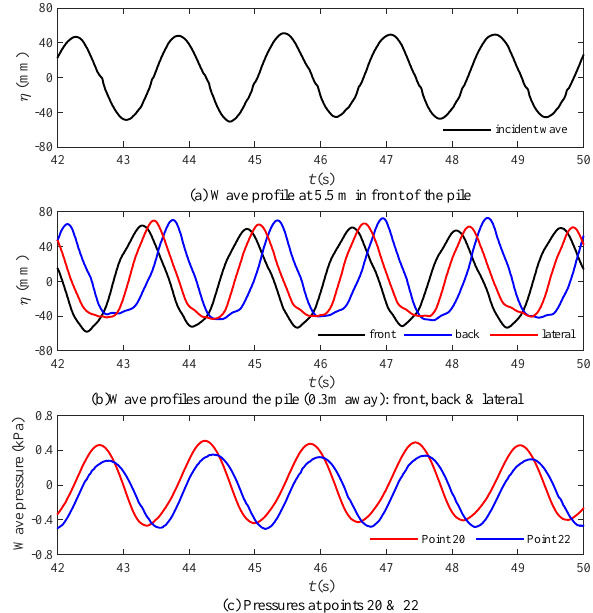
Figure 7. Distribution of wave profiles and wave pressures on the mono-pile vs time. ( a ) Wave profile 5.5 m from the mono-pile; ( b ) wave profiles around the mono-pile (0.3 m away); and ( c ) wave pressures on the mono-pile at Points 20 and 22 (Test 29 ( T = 1.6 s, H = 10